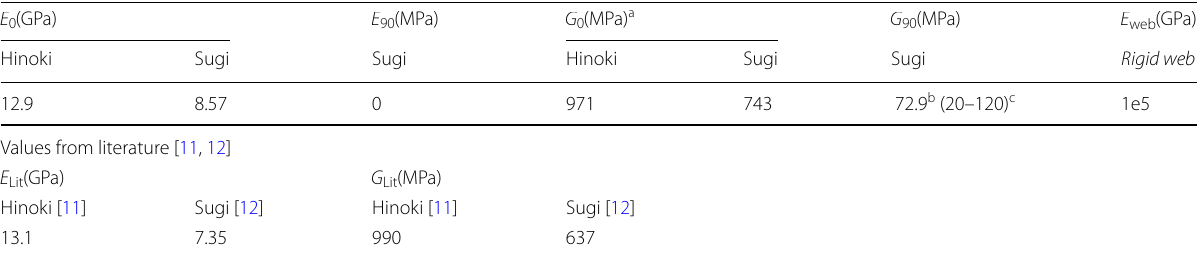
Table 4 Material constants used for the shear analogy method